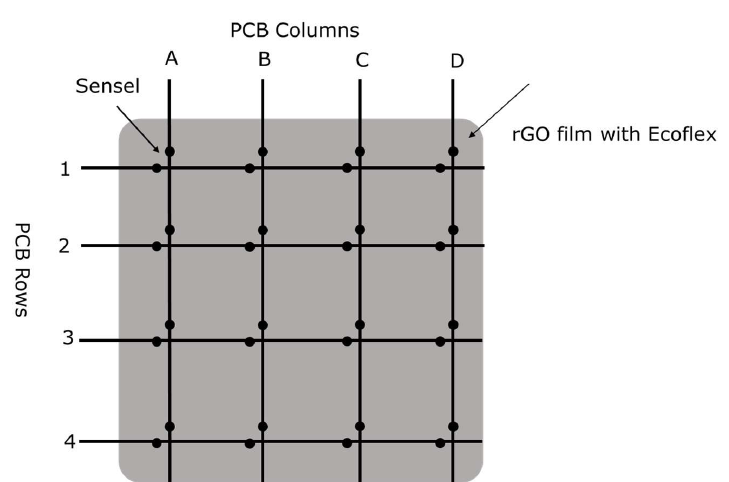
Figure 2. Schematic view of the double-layer FPCB for a 4 × 4 sensor array [32] .